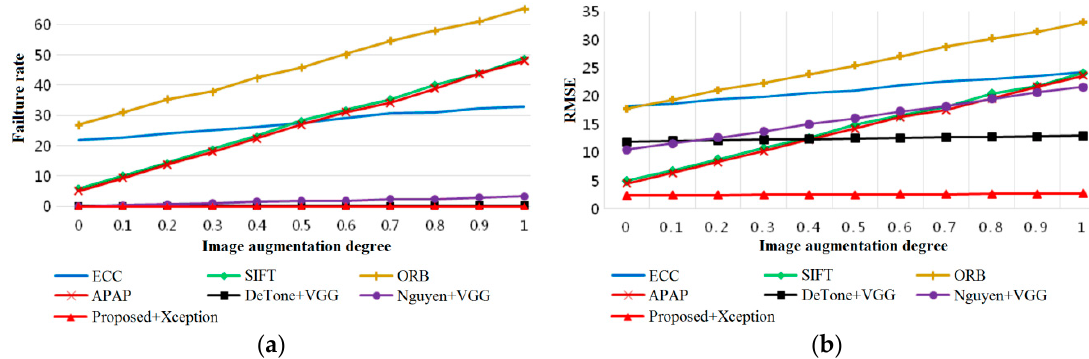
Figure 2. Robustness of seven image registration algorithms under different image augmentation degrees: ( a ) Failure rate; ( b ) RMSE.